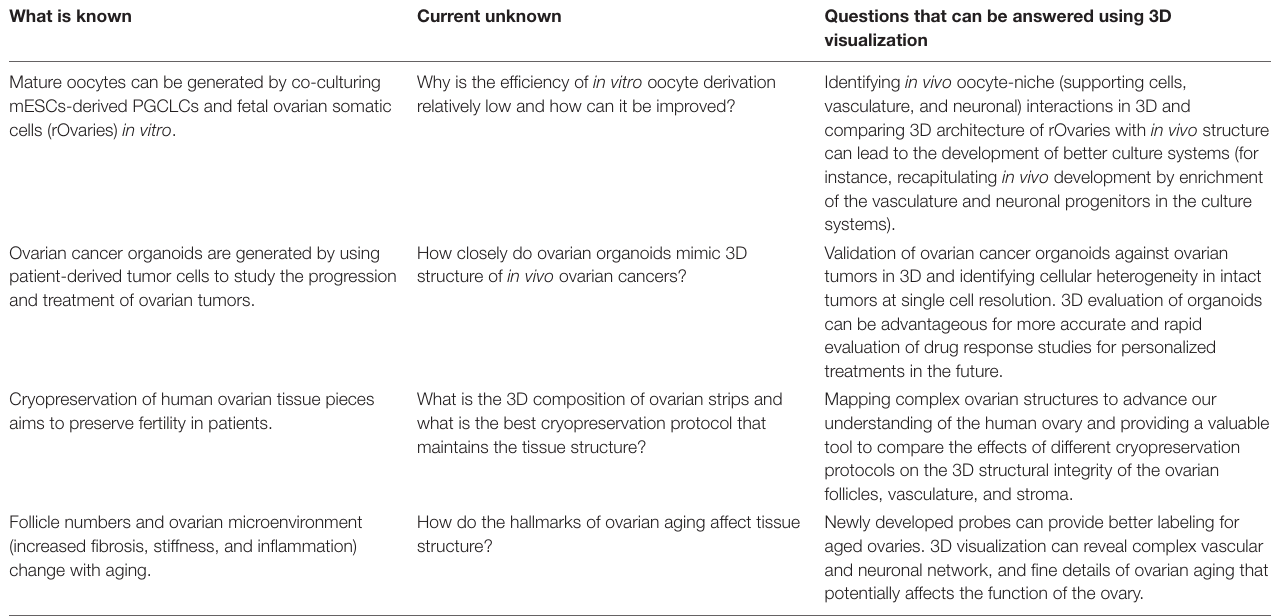
TABLE 2 | Possible future applications of 3D imaging. What is known Current